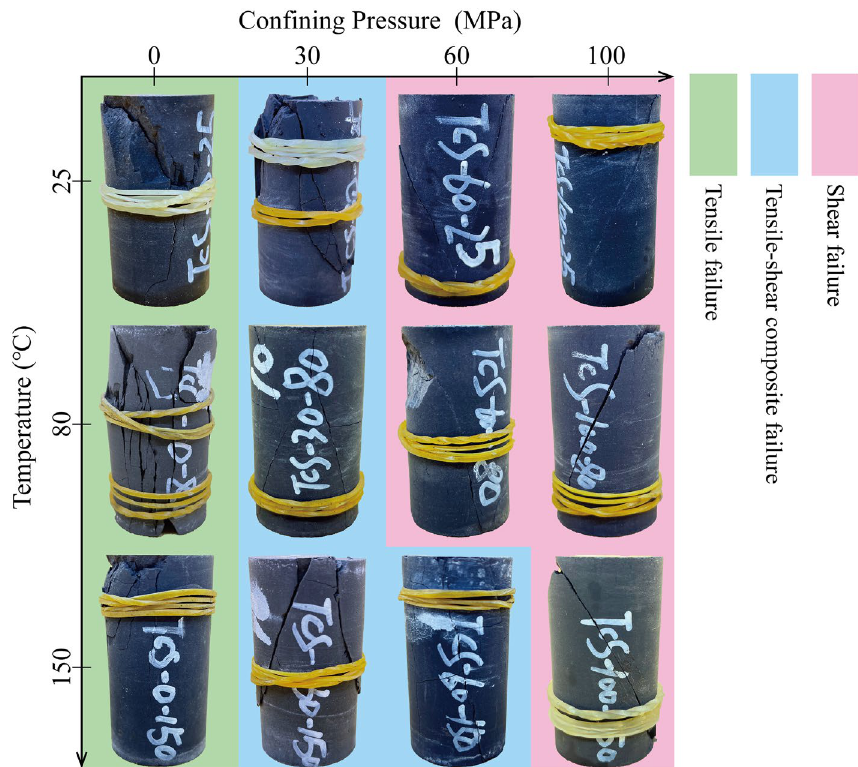
Fig. 7 Failure morphology of